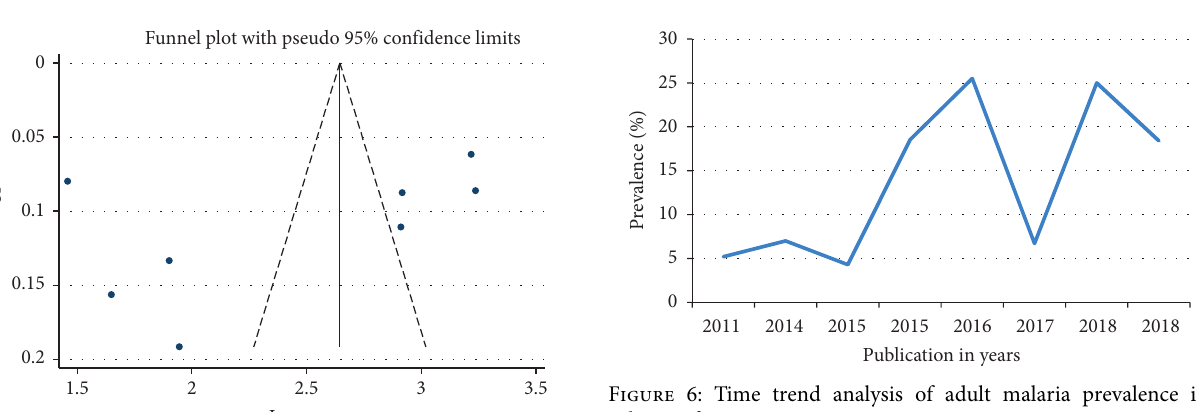
Figure 6: Time trend analysis of adult malaria prevalence in Ethiopia from 2011 to